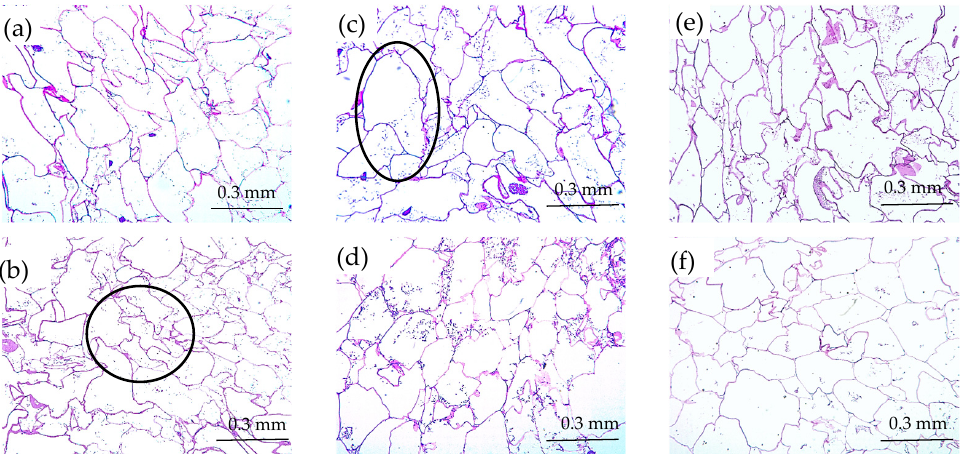
Figure 3. Optical microscope images of the red bell pepper samples: raw ( a ), treated 120 min with HPU ( b ), untreated sample ( c ), and 120 m min treated sample ( d ) after in vitro gastric digestion and untreated sample ( e ) and 120 m min treated sample ( f ) after in vitro intestinal digestion. Black ellipses indicate changes in cell size.